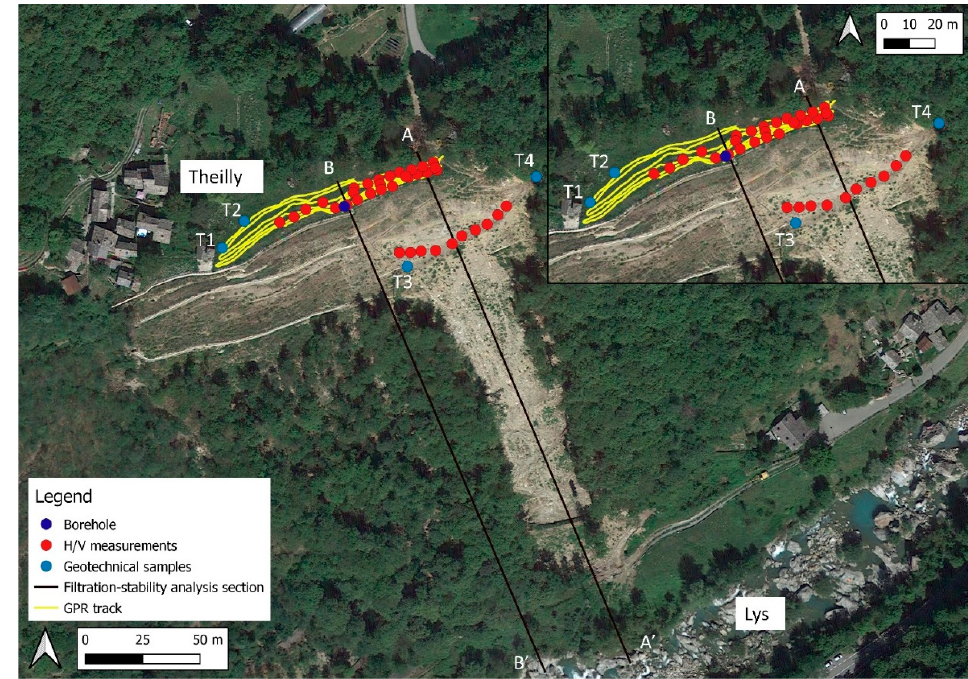
Figure 3. Location of surveys performed. Red dots are the H/V measurements, blue light dots are the point where the material samples were collected, blue dark dot is the borehole, yellow lines indicate the location of GPR tracks, and black lines are the location of the two sections (A-A’ and B-B’) modelled by fi ltration–stability analysis.